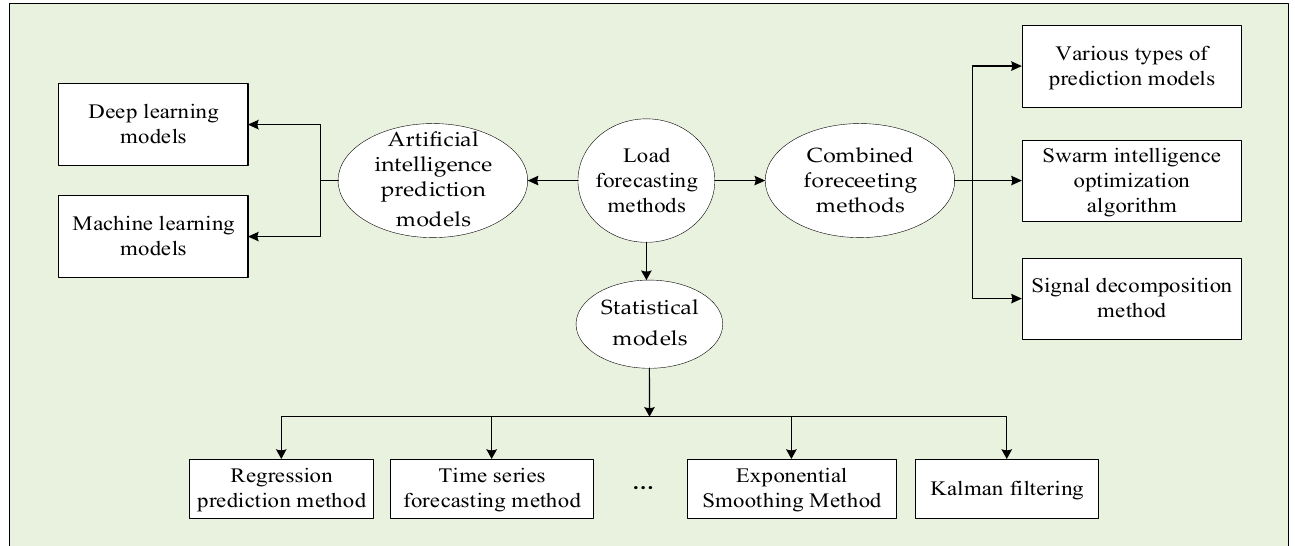
Figure 1. Classification chart of load forecasting methods.